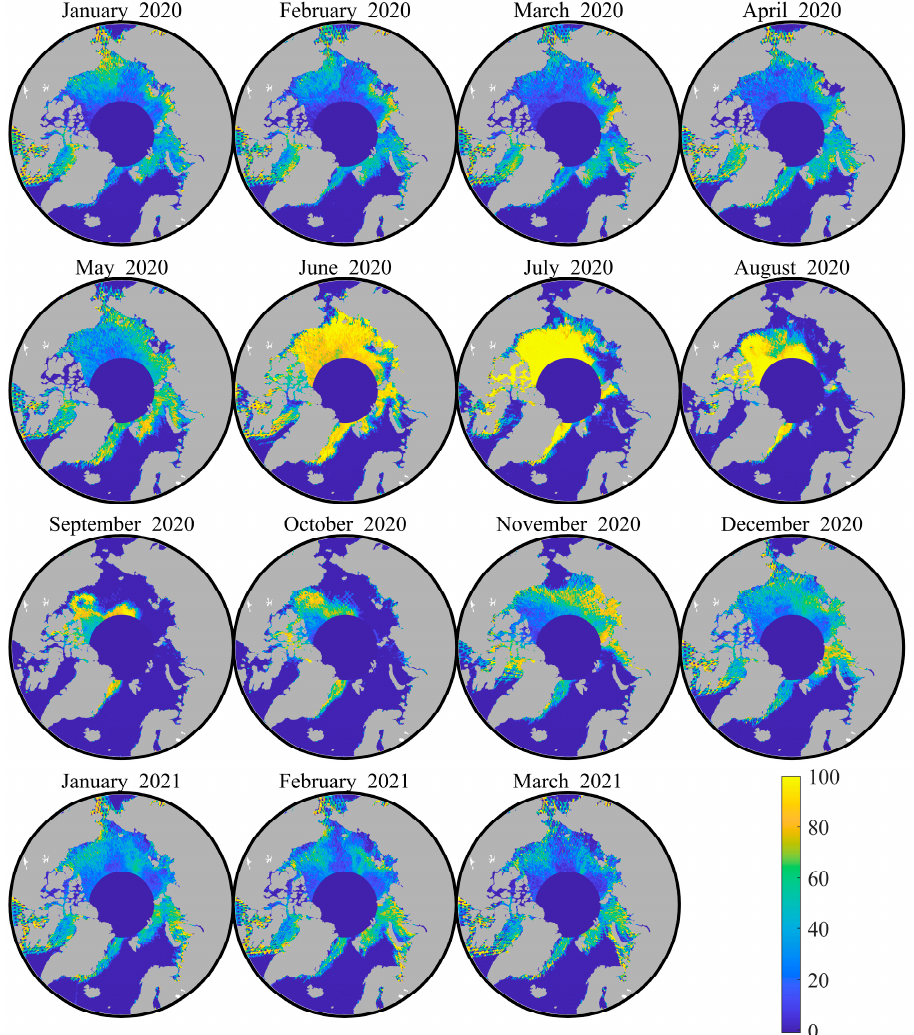
Figure A1. Lead fractions from January 2020 to March 2021 based on the HY-2B radar altimeter data and Bagging classifier.